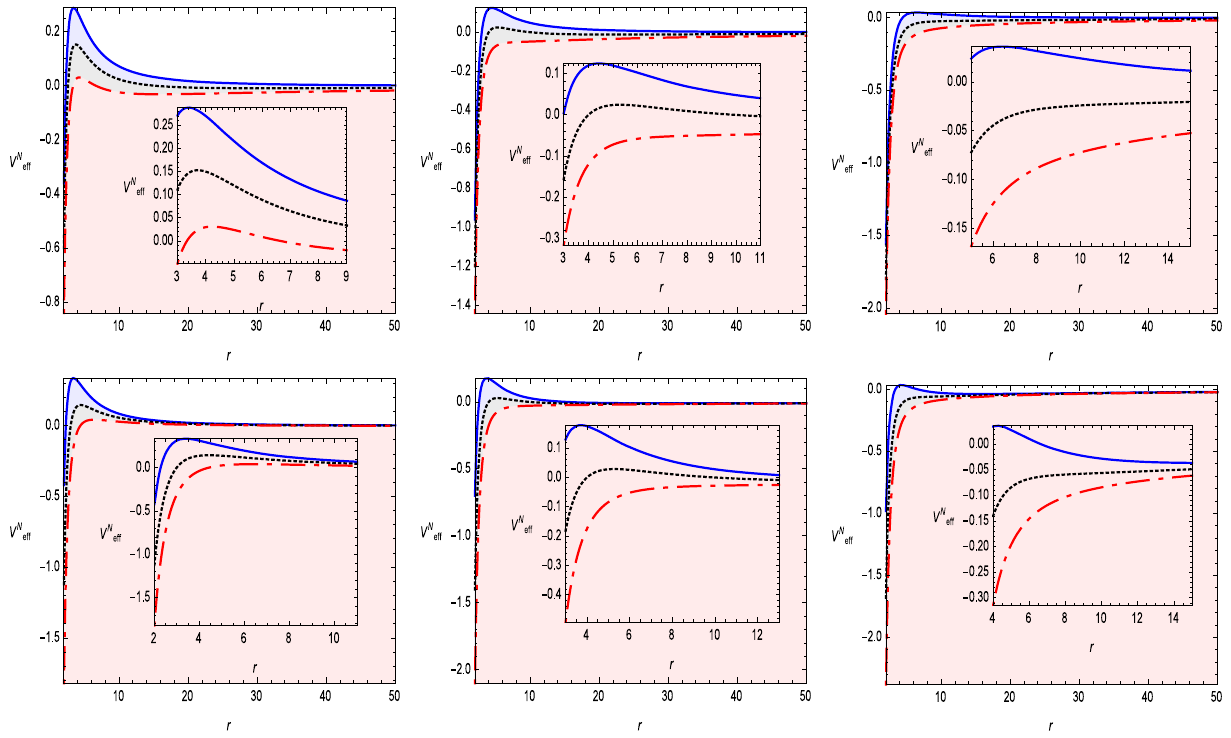
Fig. 12 Shows the behavior of V N row shows q = 0 . 01 (blue), q = 0 . 05 (black), and a = 0 . 09 (red) with for the different possible values ef f a = 0 . 1. The middle panel of first row represents q = 0 . 01 (blue), of a and q . The left panel of the first row represents a = 0 . 1 (blue), q = 0 . 05 (black), and a = 0 . 09 (red) with a = 0 . 3. The right panel of a = 0 . 3 (black), and a = 0 . 5 (red) with q = 0 . 01. The middle panel of the first row represents a = 0 . 1 (blue), a = 0 . 3 (black), and a = 0 . 5 thefirstrowrepresents q = 0 . 01(blue), q = 0 . 05(black),and a = 0 . 09 (red) with q = 0 . 05. The right panel of the first row represents a = 0 . 1 (red) with a = 0 . (blue), a = 0 . 3 (black), and a = 0 . 5 (red) with q = 0 . 09. The second